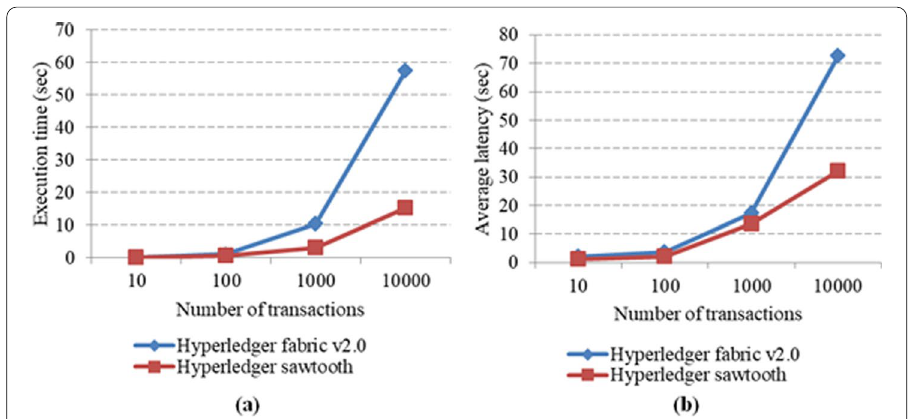
Fig. 7 Blockchain performance for simple query: a execution time and b average latency. Performance of blockchain that is third phase of the system is presented in graphical form for simple query execution. Simple query is a simple operation executed by node such as read a block. a Execution time required for simple query using Hyperledger fabric 2.0 and sawtooth is represented. b Average latency required for simple query execution on system when implemented using Hyperledger v2.0 and sawtooth is graphically represented